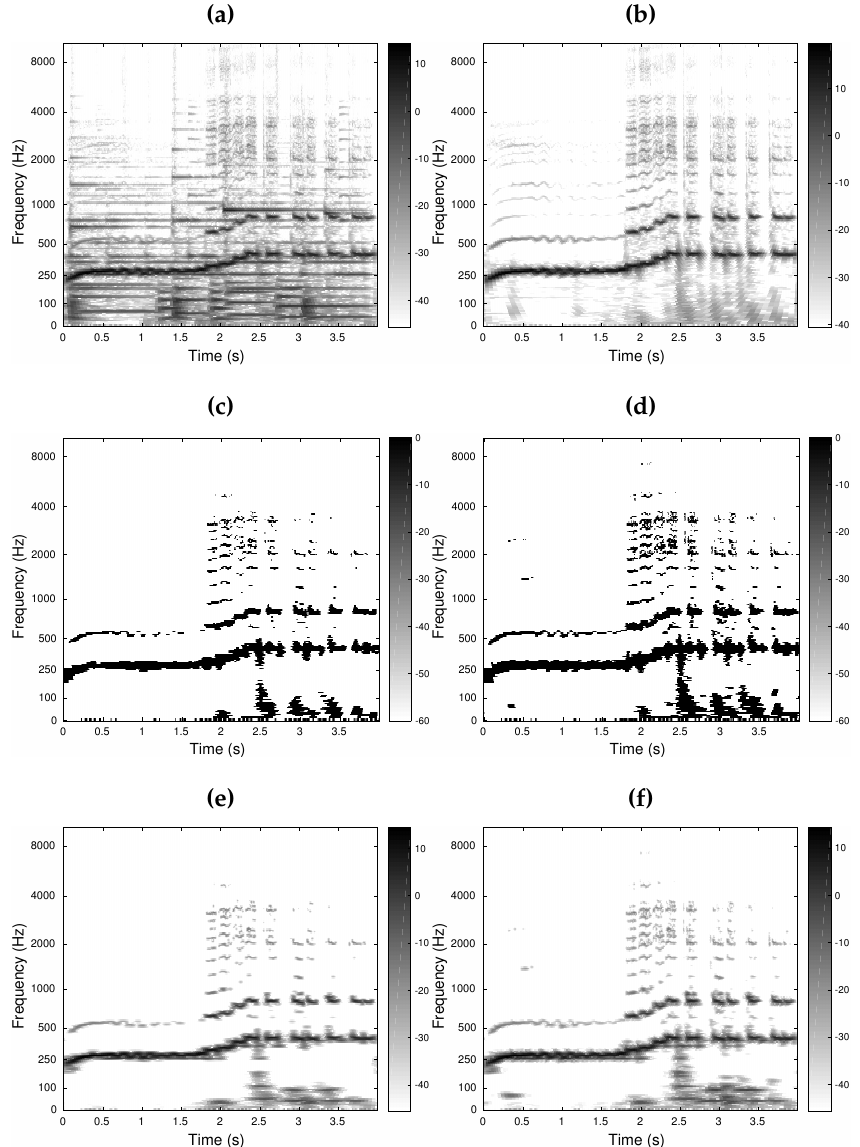
Figure 5. Source separation for R t = 4 and β = 1/6 displayed as time-frequency (TF) plots: the magnitude of each sub-band component (in dB) as a function of time (in s). ( a ) Shows the mixture analyzed by a gammatone FB; ( b ) Shows the target (voice) analyzed by a gammatone FB; ( c ) Shows the binary mask obtained for Audlet_hann; ( d ) Shows the binary mask obtained for trev_gfb and Audlet_gfb—the black and white dots in the masks represent ‘1’ and ‘0’ entries, respectively; ( e , f ) Show the target separated by Audlet_hann and Audlet_gfb,